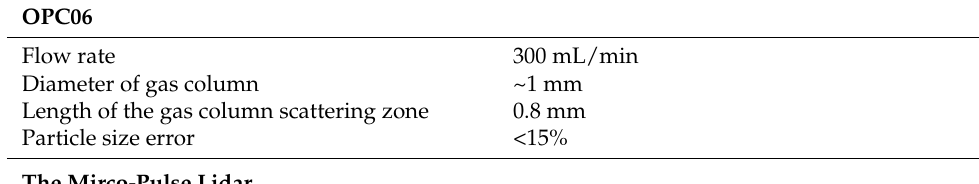
Table 2. Information on OPC06 as well as the micro-pulse lidar used in the